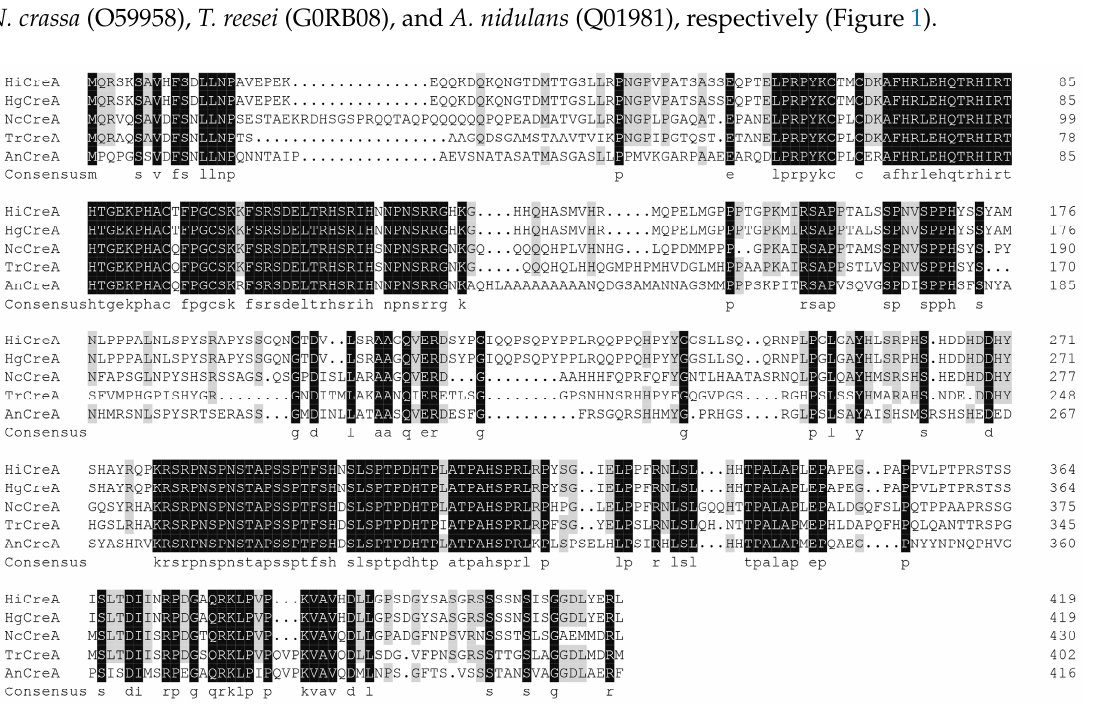
Figure 1. Multiple protein sequence alignment of the deduced CreA sequence from H. insolens with four CreA counterparts. The sequences shown are CreA from H. insolens , HgCreA from H. grisea (O93781), NcCreA from N. crassa (O59958), TrCreA from T. reesei (G0RB08), and AnCreA from A. nidulans (Q01981). Identical and conserved residues are shaded in black and gray, respectively.